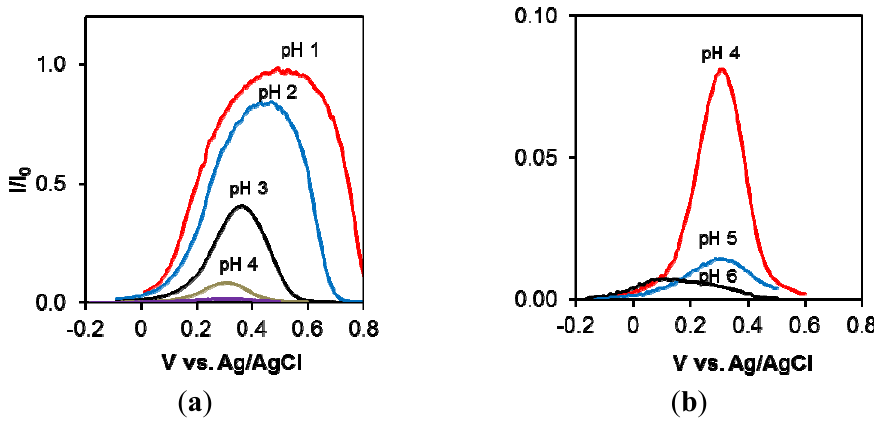
Figure 4. Conductance current vs. potential of polyaniline in various pH solutions: